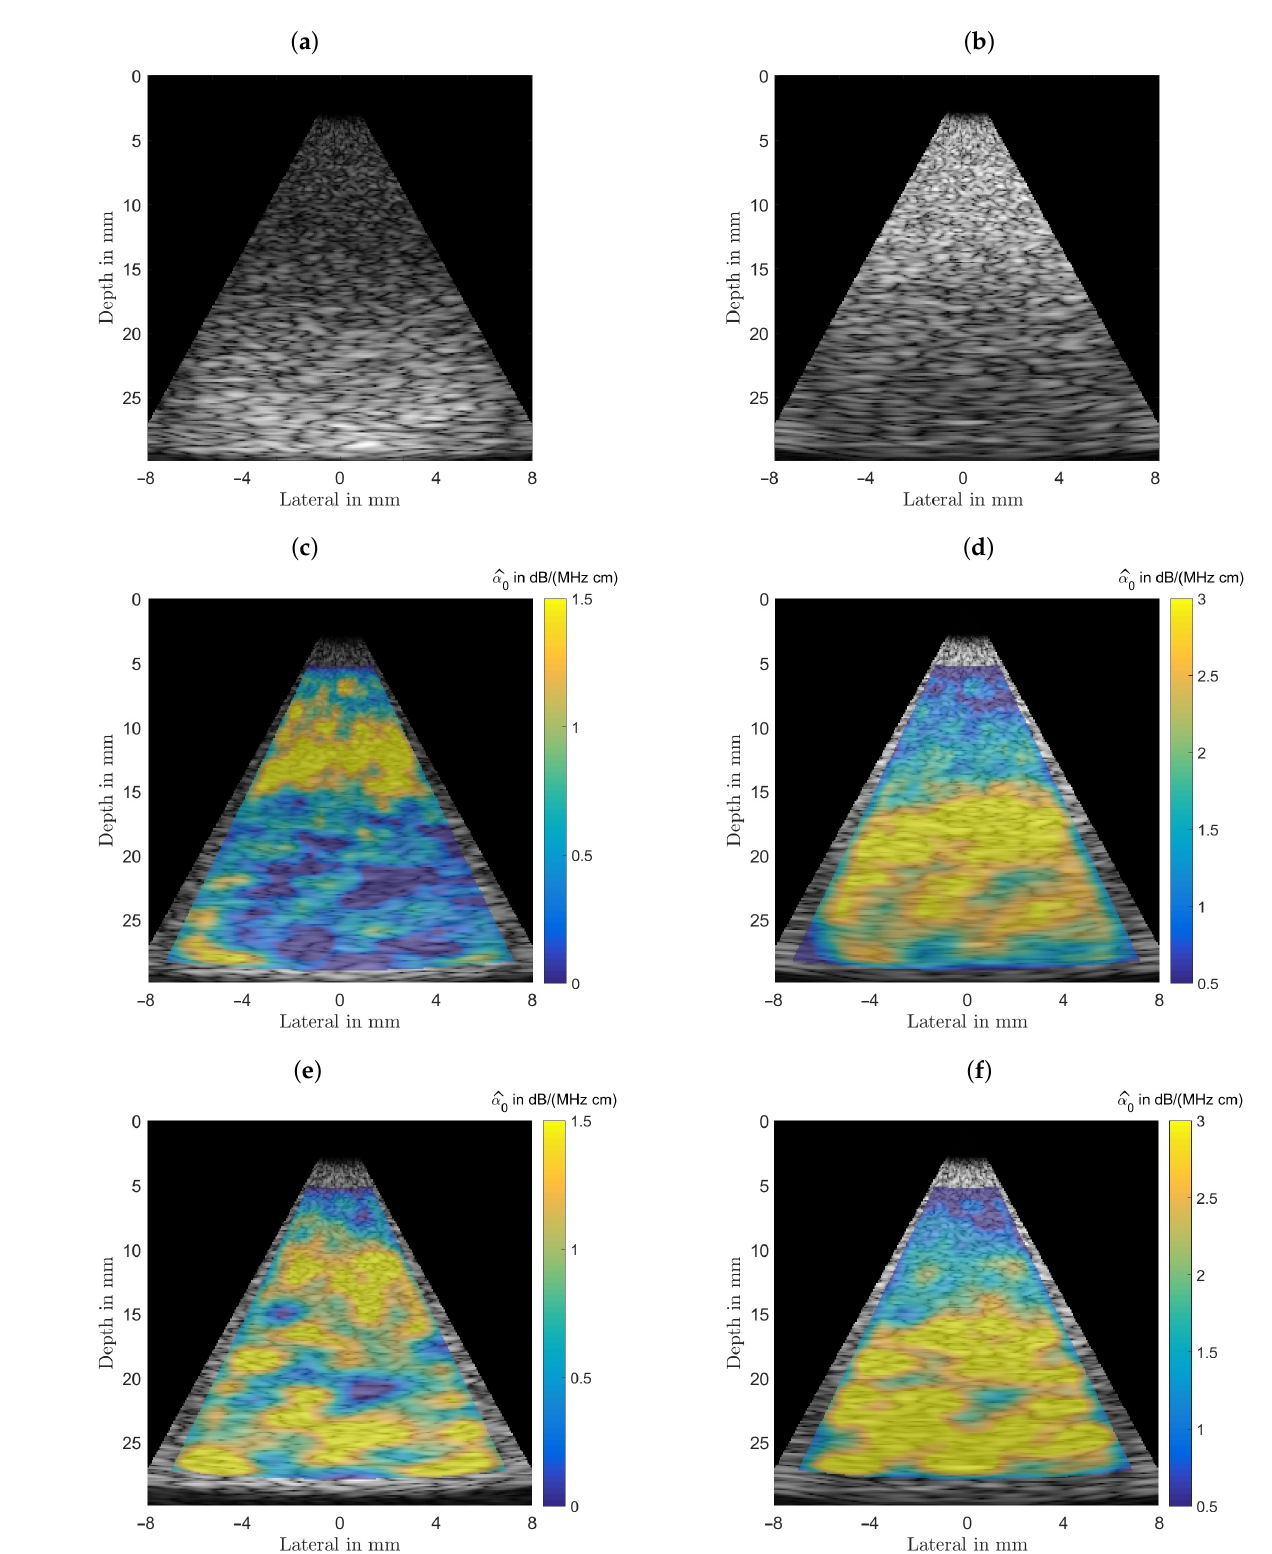
Figure 9. ( a ) B-mode images of an inclusion with a radius of 7.5 mm positioned centered at a depth of 20 mm, left, the inclusion is mimicking a cyst ( α 0 = 0.2 dB/(MHz cm)). ( b ) B-mode images of an inclusion with a radius of 7.5 mm positioned centered at a depth of 20 mm, the inclusion is mimicking a malignant lesion ( α 0 = 2.5 dB/(MHz cm)). ( c , d ) Estimation results obtained from the application of the spectral-log-difference algorithm. ( e , f ) Estimation results obtained from the